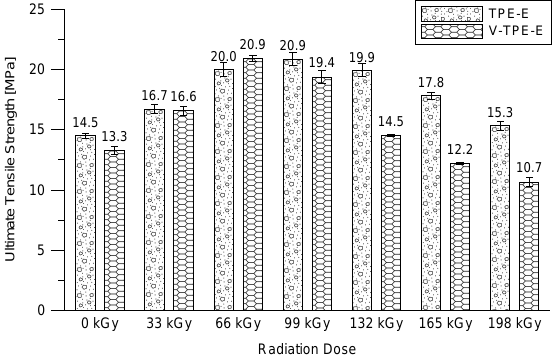
Figure 10. Ultimate tensile strength dependence on the radiation dose.